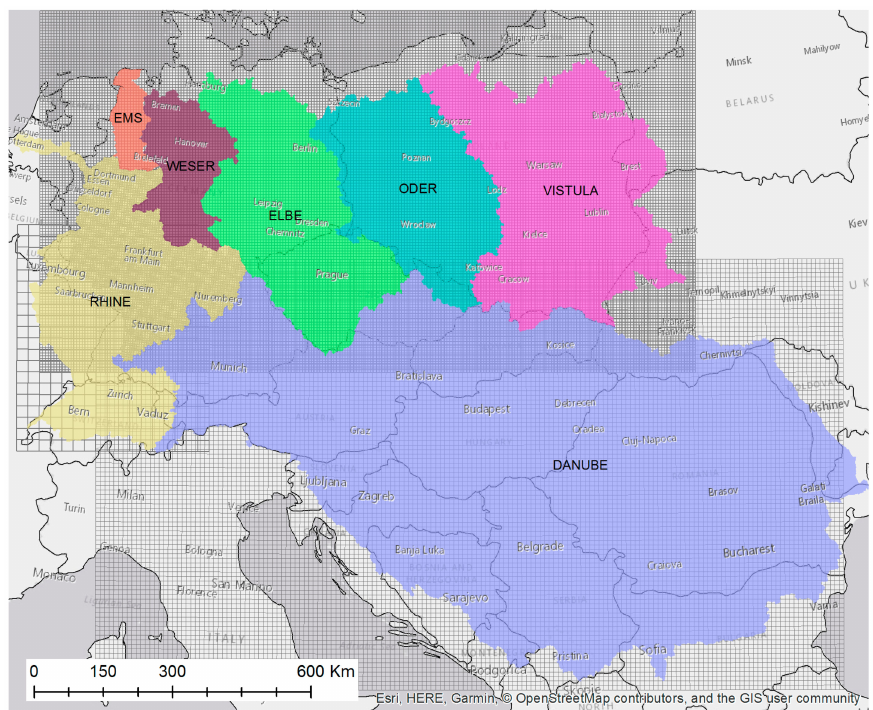
Figure 4. Impact Forecasting European Flood Model: the actual basin coverage